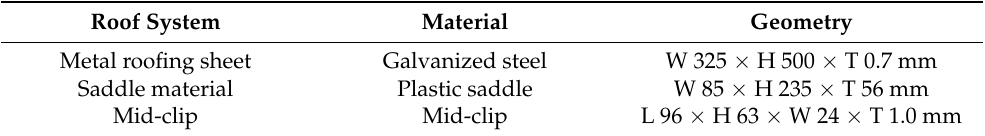
Table 1. Material components of the lab-scale SSMR test.